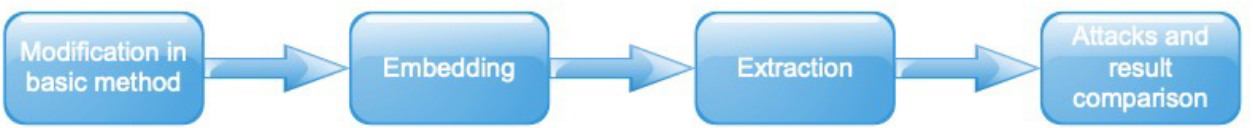
Figure 5. Proposed workflow.